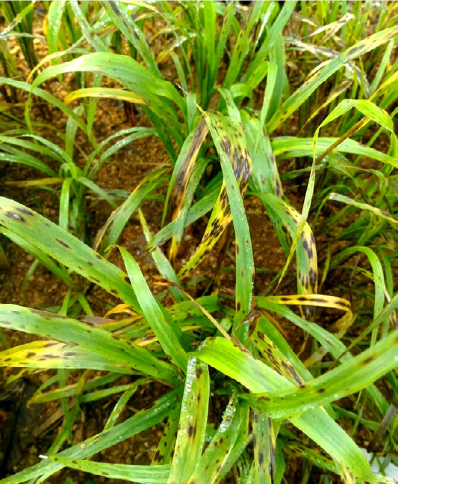
Fig. 2. Susceptible check plant with Blast spots Fig. 3. Resistant plants without disease